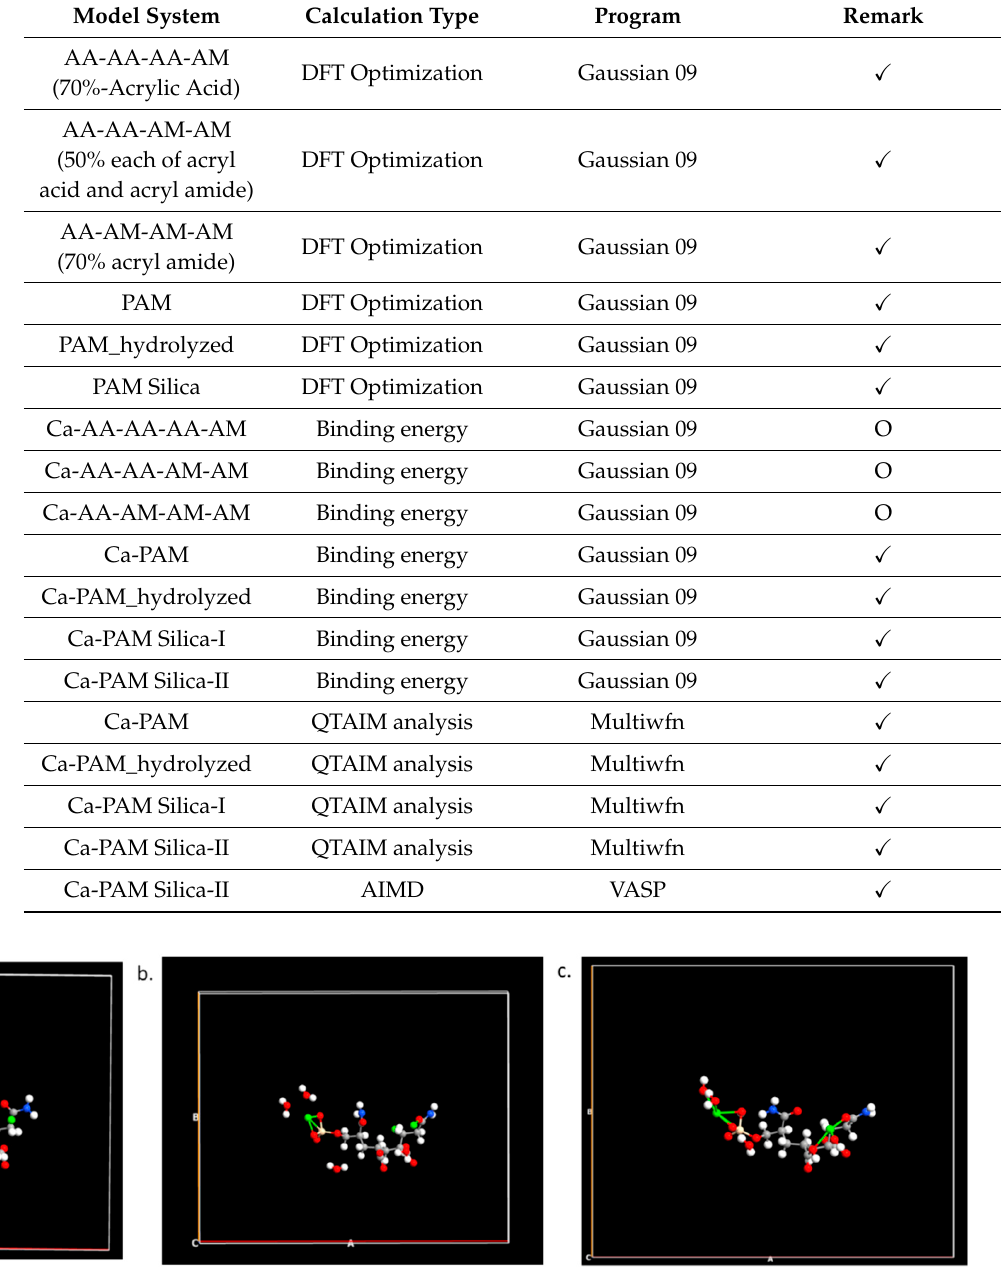
Table 2. Summary of model systems and calculation types.